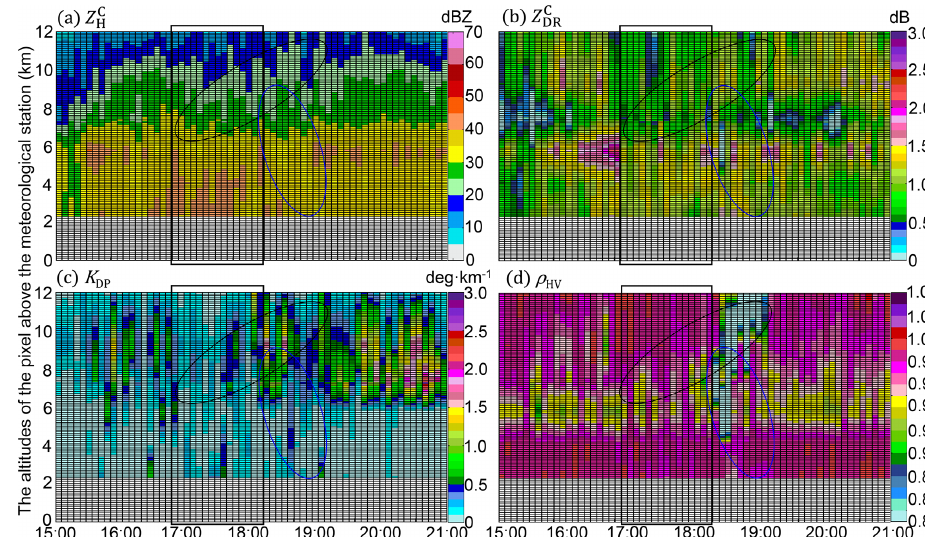
Figure 14. The same as Fig. 12 but for the HJ station between 15:00UTC, 8 August 2019, and 21:00UTC, 9 August 2019.